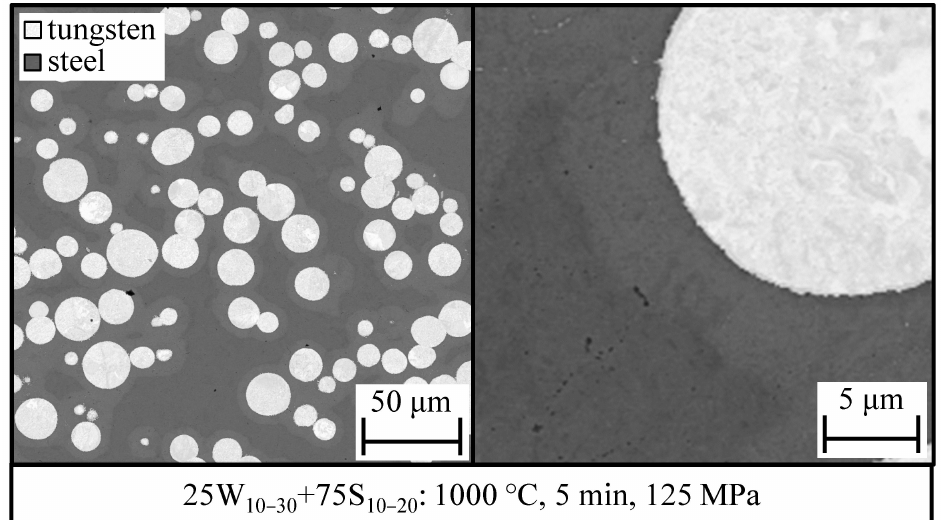
Figure 2. Cross-sectional SEM micrograph of 25 W composite sintered with optimized parameters (1000 ◦ C, 125 MPa, 5